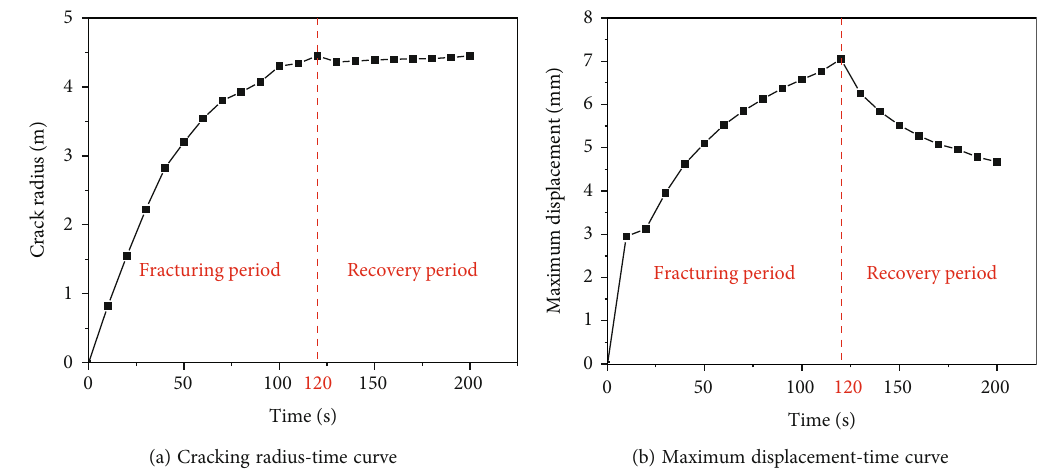
Figure 13: Fracturing e ff ectiveness at di ff erent times.